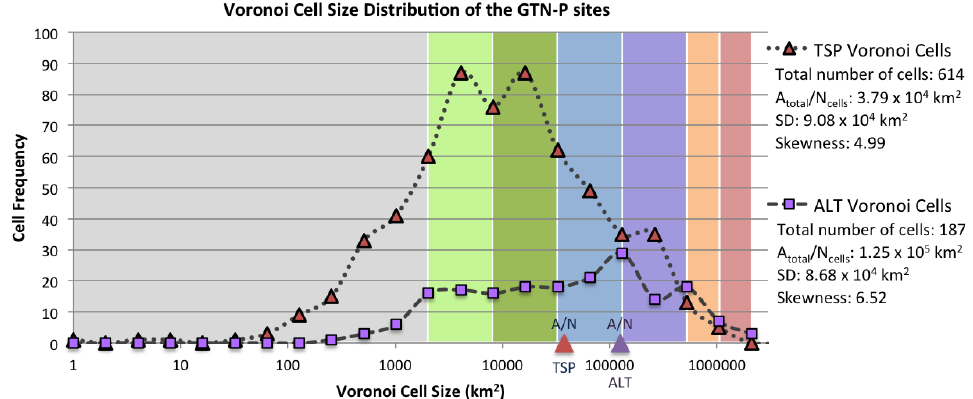
Figure 6. Voronoi cell size distribution according to the Voronoi tessellation analysis on the spatial distribution of boreholes (TSP) and active layer sites (ALT).